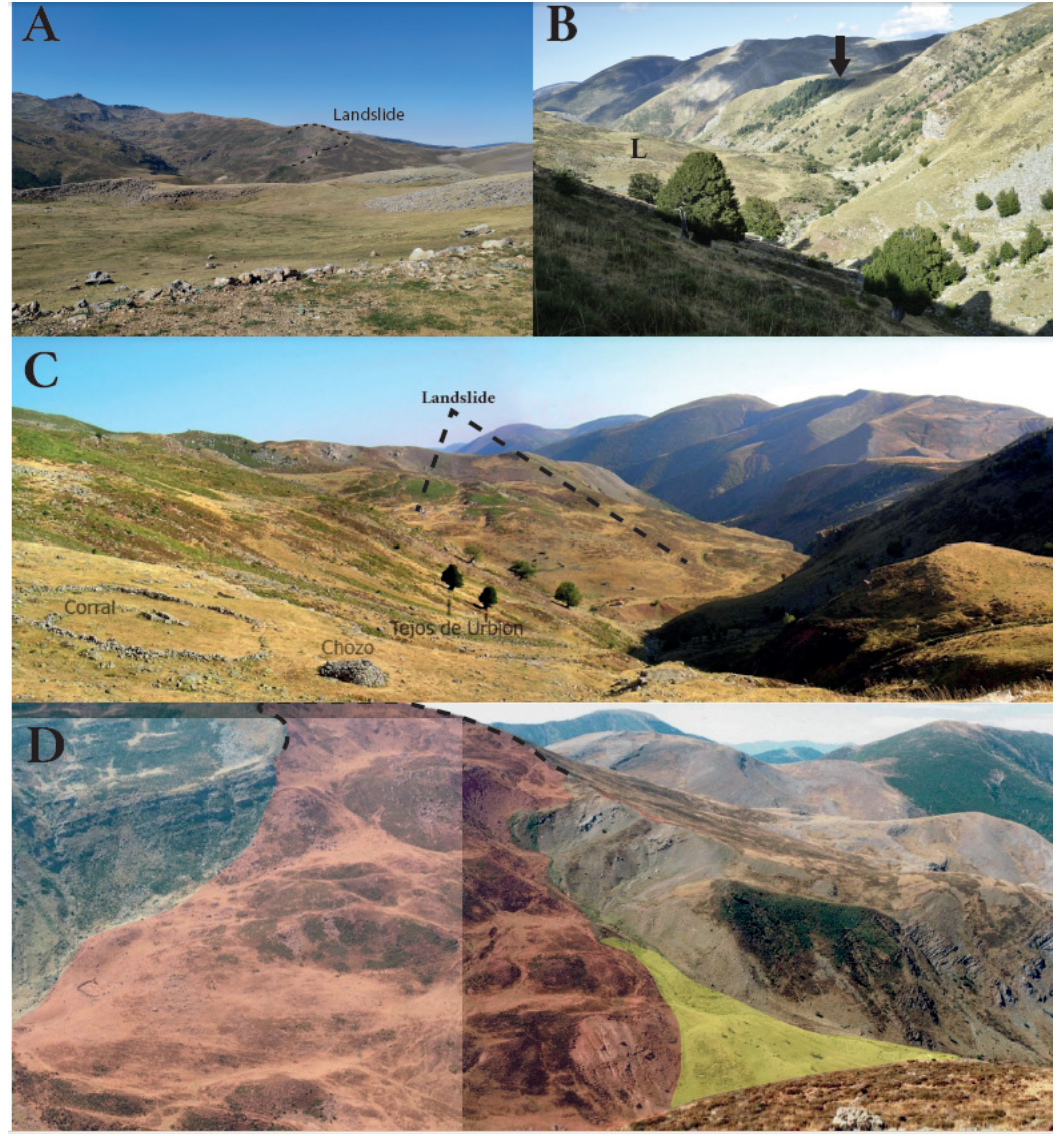
Figure 3. ( A ) General aspect of the valley of glacial origin of the Urbión river with indication of the head of the landslide. In the background Picos de Urbión (2228 m); ( B ). View of the bottom of the landslide (L). The arrow indicates the location of the right lateral moraine of the glacier maximum; ( C ). View of the landslide from upstream of the Urbión River Valley. Slope landslide of the Urbión river valley; ( D ). Front view of the landslide and alluvial fan (shaded). Note the lateral moraine on the left margin.